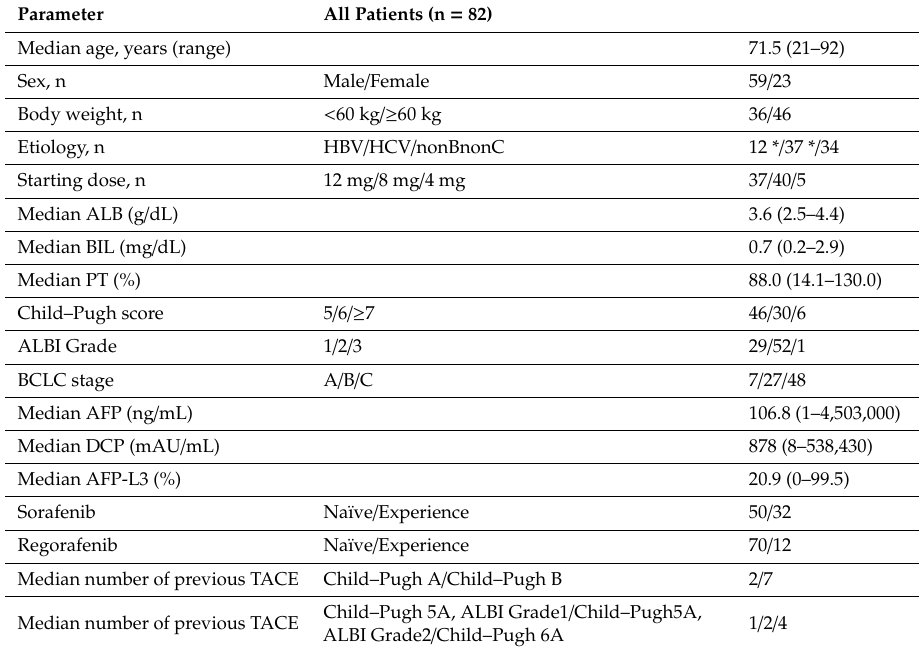
Table 1. Patient